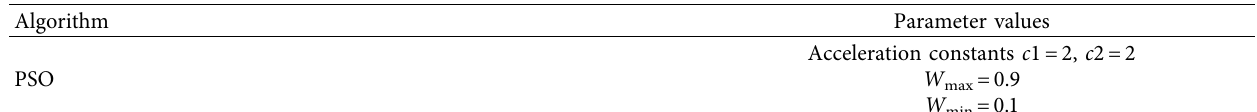
Table 14: Te proposed POCSO algorithm parameters.